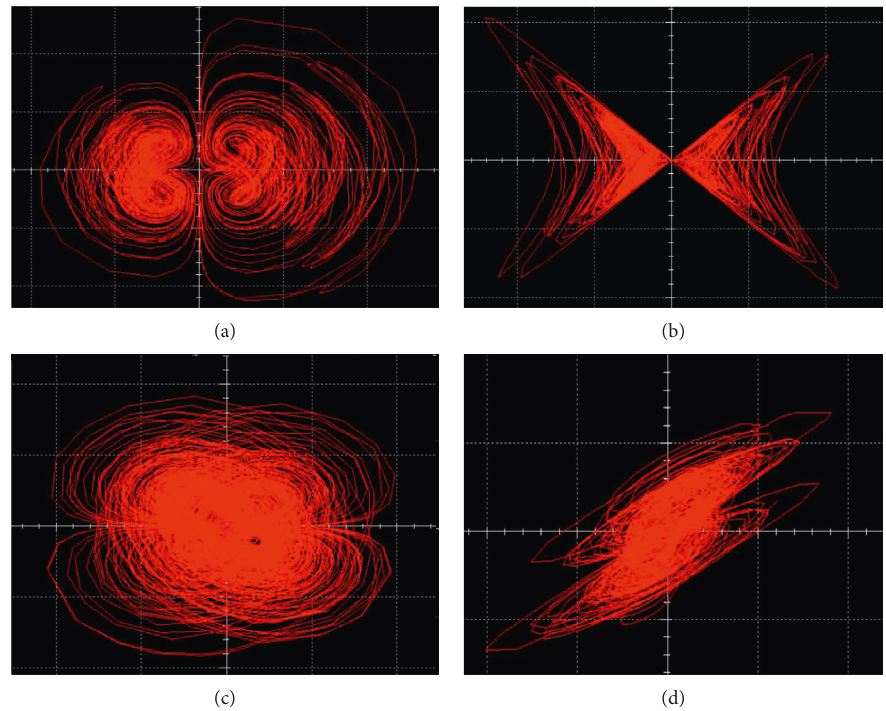
Figure 8: Four-wing memristive hyperchaotic phase portraits obtained by Multisim simulations in the (a) x − x plane, and (d) x (c) x 2 3